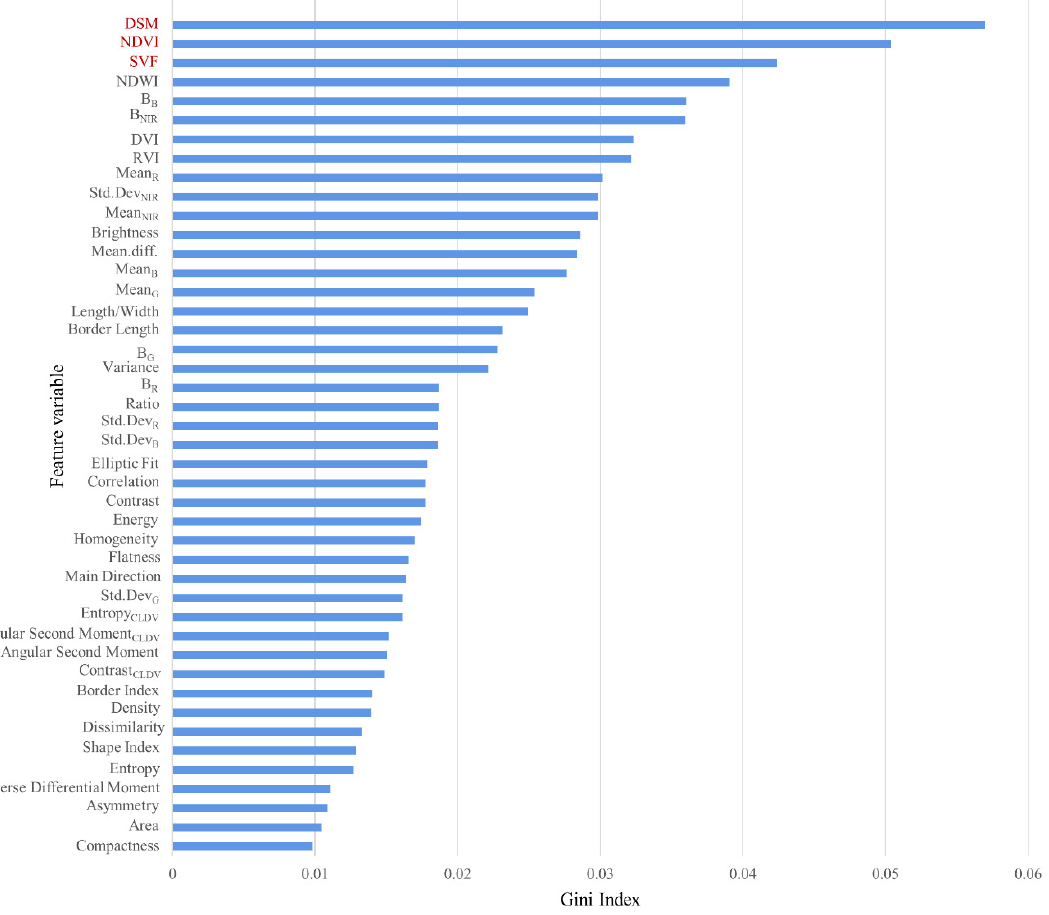
Figure 4. Variable importance ranking for land cover mapping revealed by the RF algorithm.